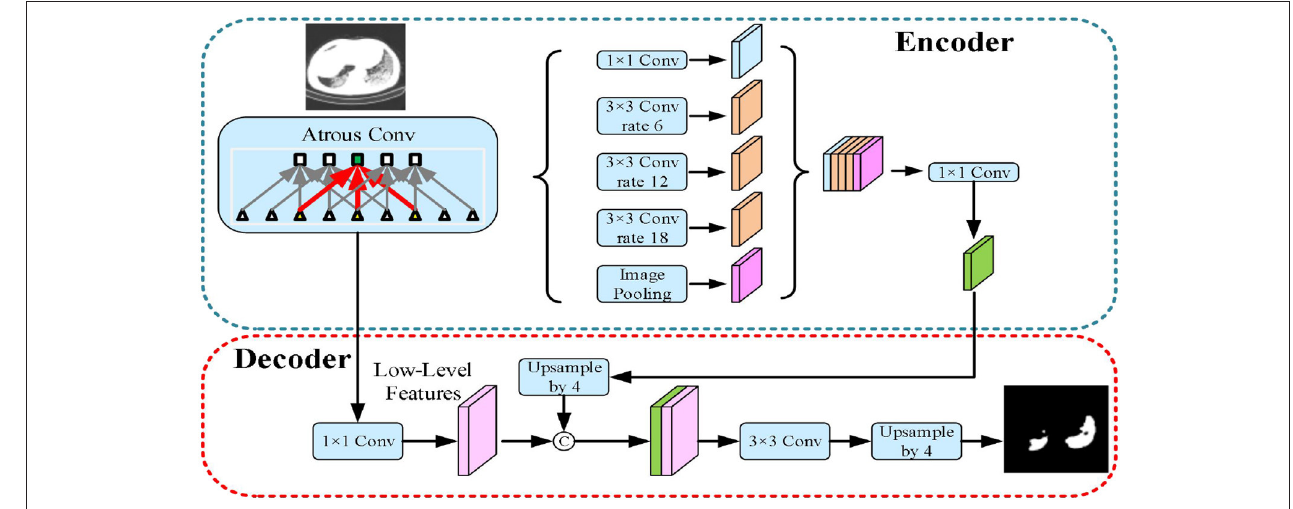
FIGURE 6 | DeepLabv3 + model.